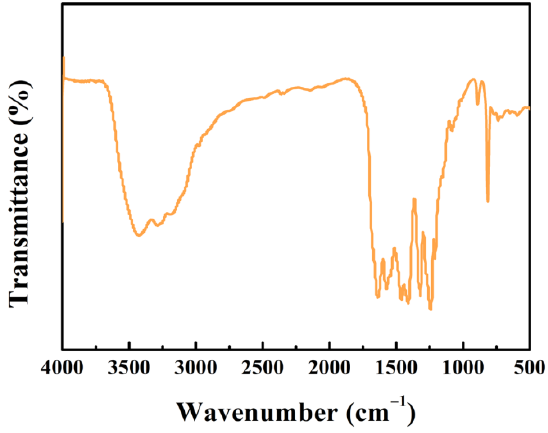
Figure 3. FTIR spectra of g-C 3 N 4 .